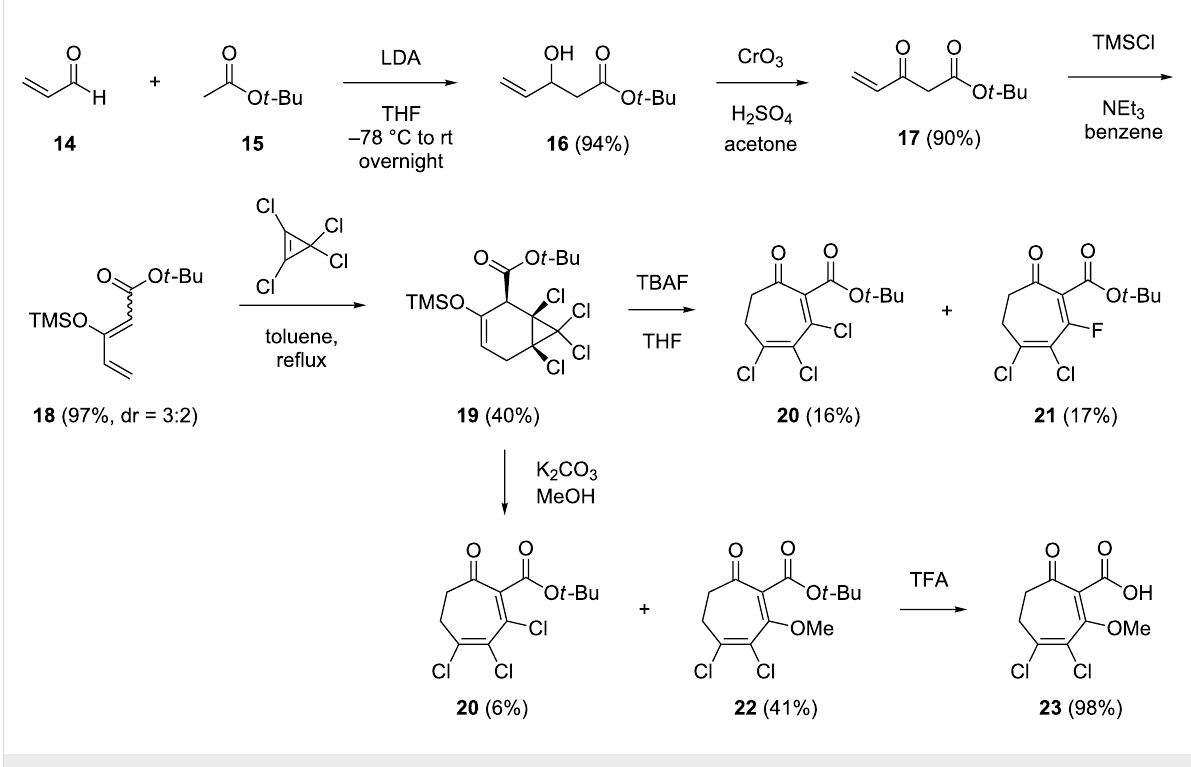
Scheme 2: Synthesis of halogenated TDA